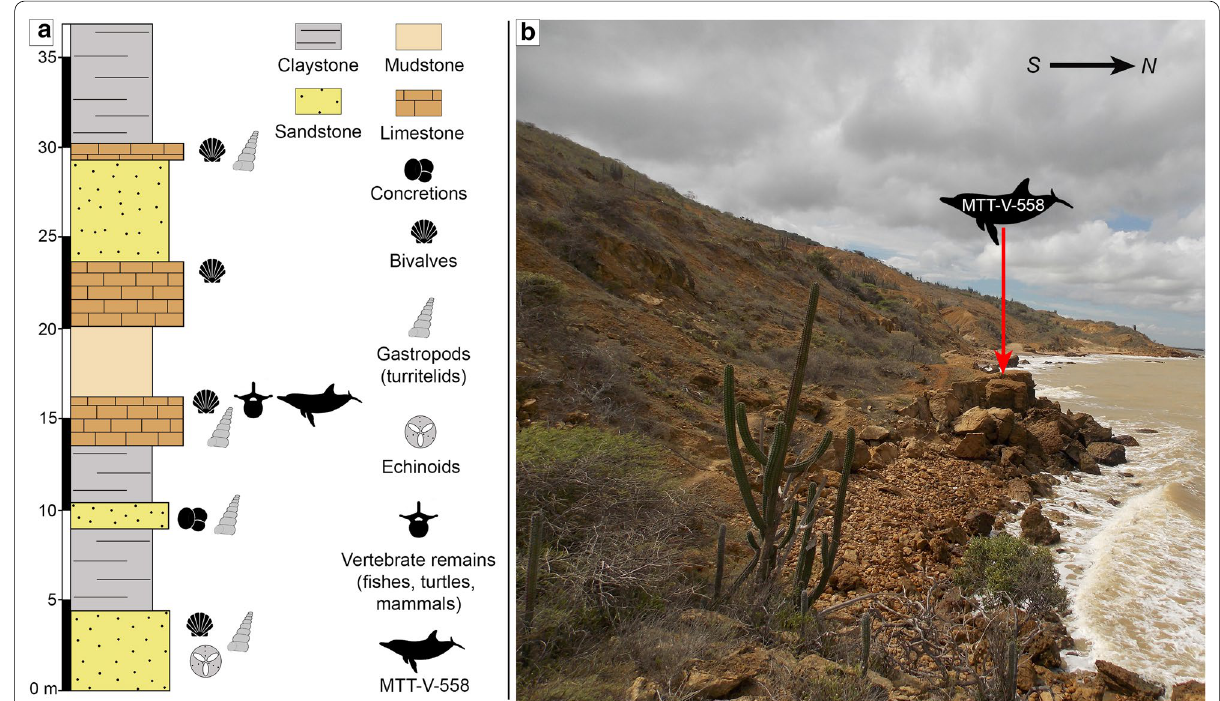
Fig. 2 General stratigraphic section of the fossiliferous locality where the specimen MTT‑V‑558 was collected. The dolphin silhouette shows the fallen block where the specimen was